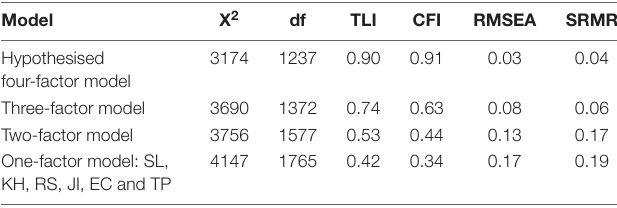
TABLE 2 | Results of the confirmatory factor analysis ( N = 363). Model